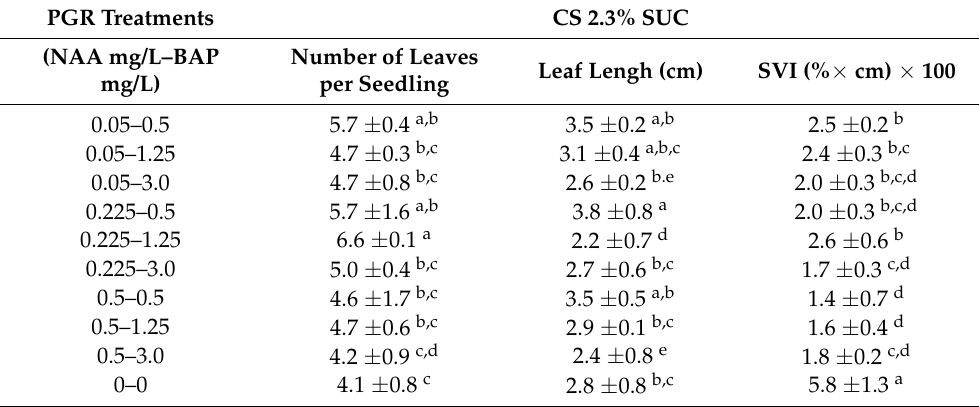
Figure 4. Development of Taraxacum officinale plantlets at ( a ) 2 weeks, ( b ) 3 to 8 weeks in vitro and ( c ) transferred plantlets 16 weeks after sowing for greenhouse acclimation. The size of the bars is 1 cm. Table 4. Number of leaves per seedling, leaf length and vigor index of Taraxacum officinale seedlings under optimal carbon source (2.3% sucrose), at different treatments of PGRs. Medium supplemented NAA and BAP (in combinations) at 18 ◦ C and photoperiod 18/6 h light/dark in a 3-week period. Sucrose (SUC); Plant growth regulators (PGR); Carbon Source (CS); Seedling Vigour Index (SVI). Letters superscript indicate significant differences from control at p ≤